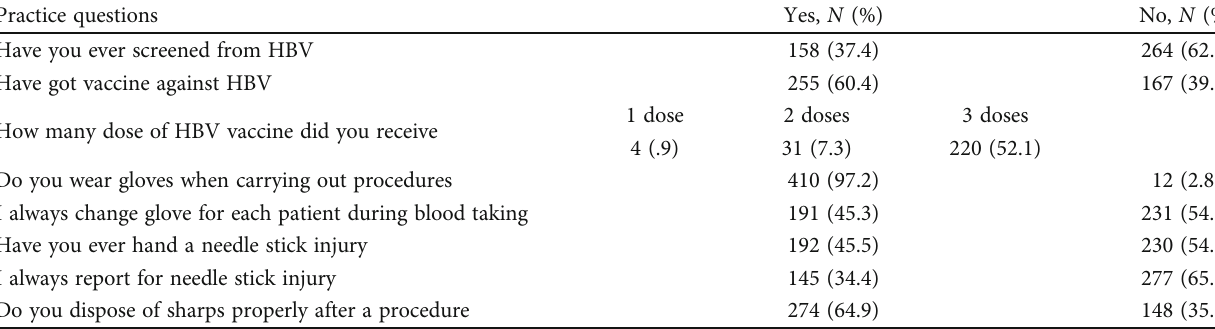
Table 6: Practice-related questions about HBV early detection, transmission, and